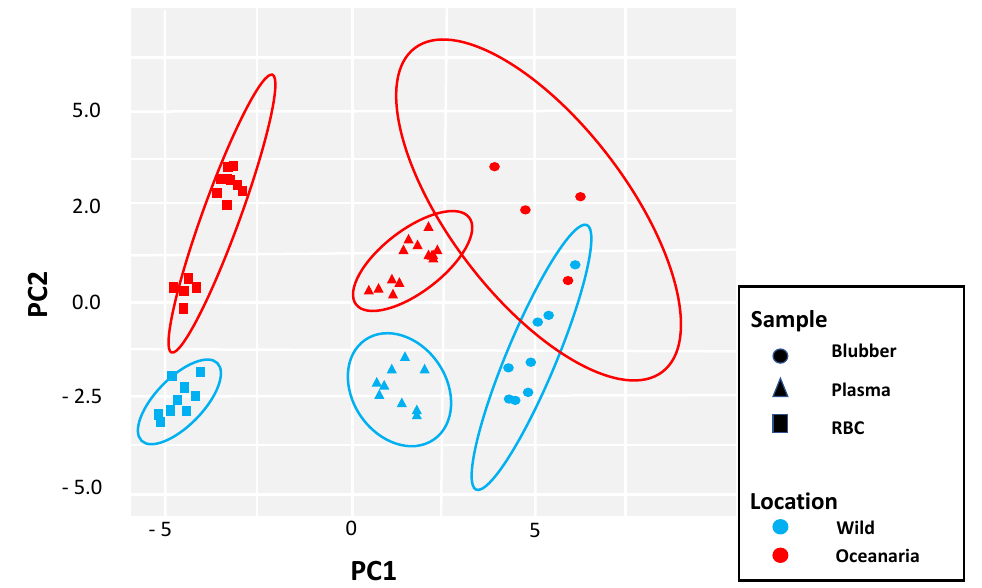
Figure 6. Principal component analysis (PCA) of fatty acid signatures in blubber, plasma, and RBCs of 9 wild belugas (BBB; blue) and 14 oceanaria-based belugas (OBB; red). Ellipses show 95% confidence intervals (CIs) around each sample type. PC1 and PC2 explain 65% of the variance.